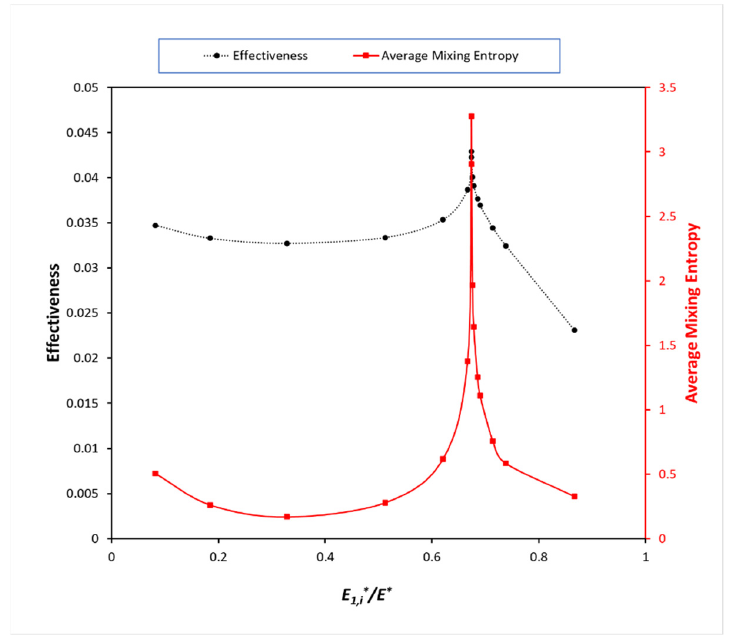
Figure 5. Effectiveness and averaged mixing entropy as a function of the fraction of the initial mechanical energy to the total energy.